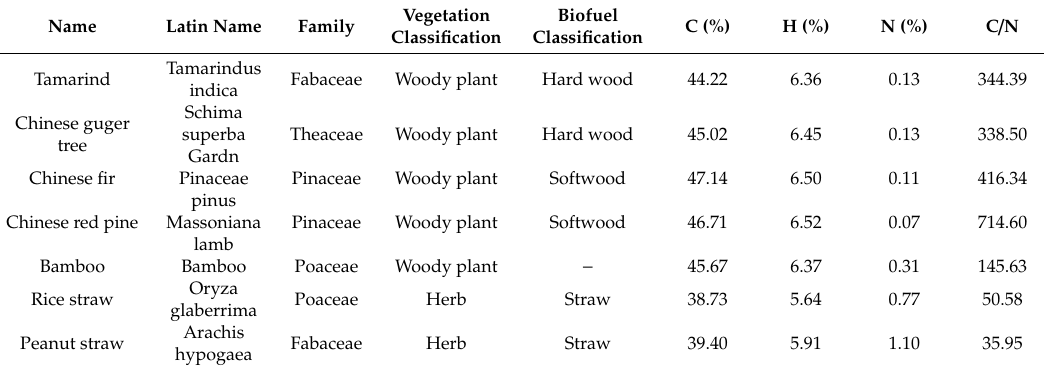
Table 1. Vegetation species used in this study, including their classification and elemental